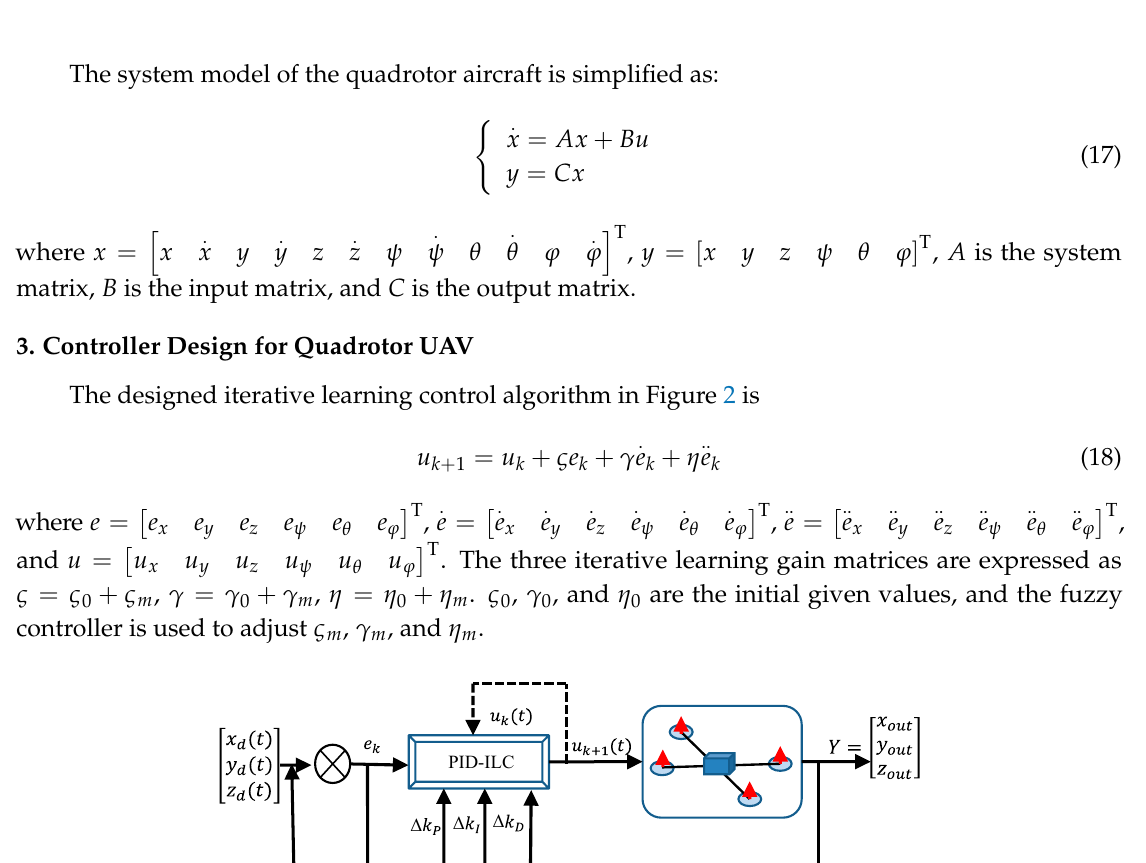
Figure 2. System architecture of the fuzzy PID-ILC for the quadrotor.